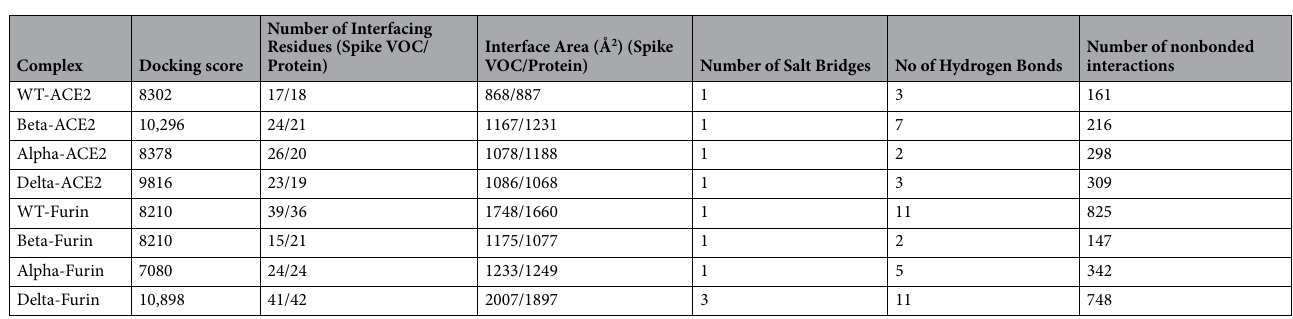
Table 1. Summary of docked ACE2 and furin protein to SARS-CoV-2 spike WT and VOCs. The results are represented as Patchdock docking scores and PDBsum binding interaction analysis of the binding